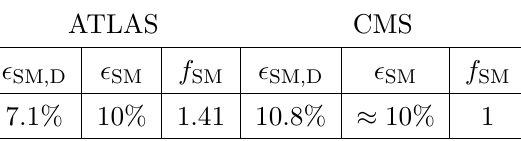
Table 3 . Results from the ATLAS and CMS-like recast. See text for